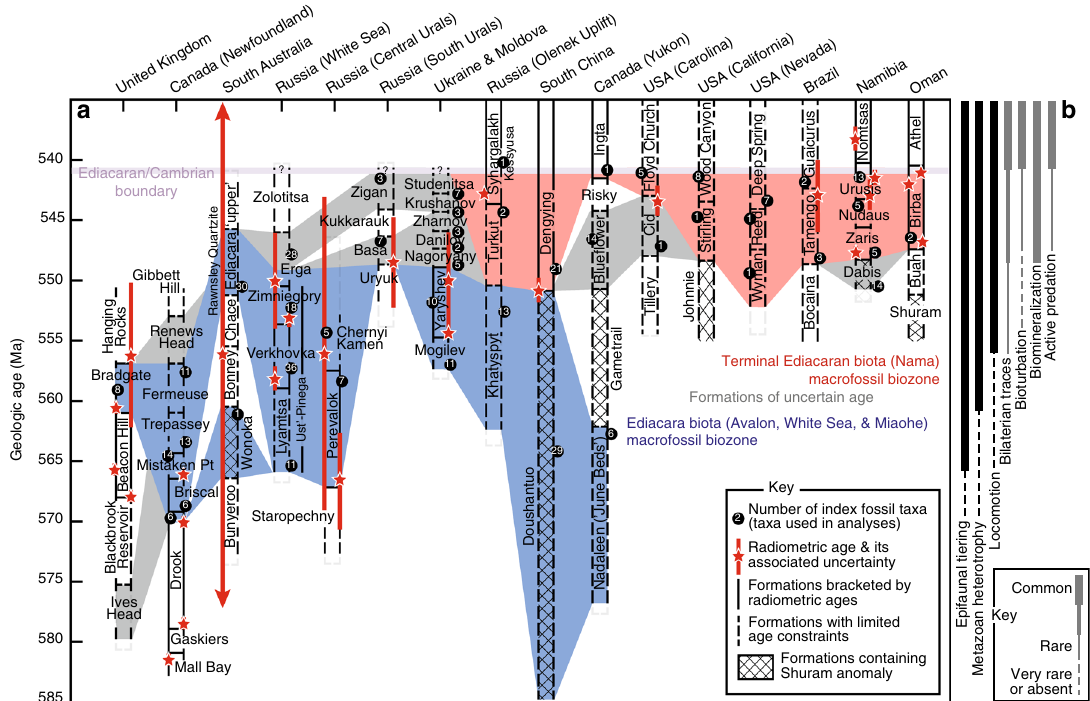
Fig. 5 Ediacaran stratigraphy and chronology of evolutionary events. a Stratigraphic distribution of Ediacaran biozones identi fi ed with network analysis. White formations contain no potential index fossils. b Ediacaran histories 3 of epifaunal tiering 17 , metazoan heterotrophy 14 , locomotion 14,69 , bilaterian traces 12,55 , bioturbation 18,19,70 , biomineralization 9,10 , and predation 13,20 . Source data are provided as a Source Data fi